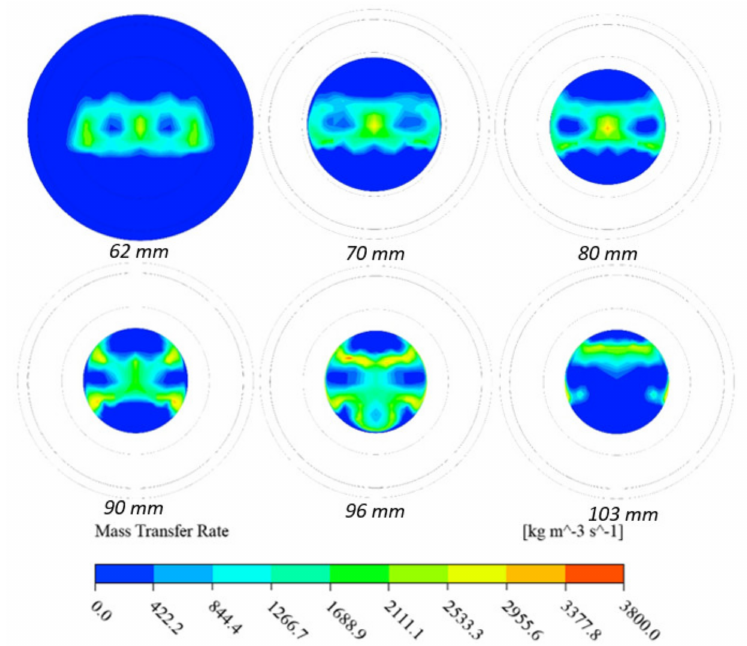
Figure 19. Mass transfer rate for two-nozzle design.